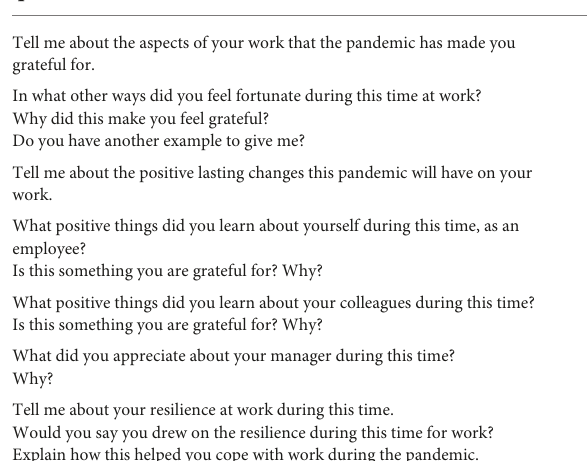
TABLE 2 Interview